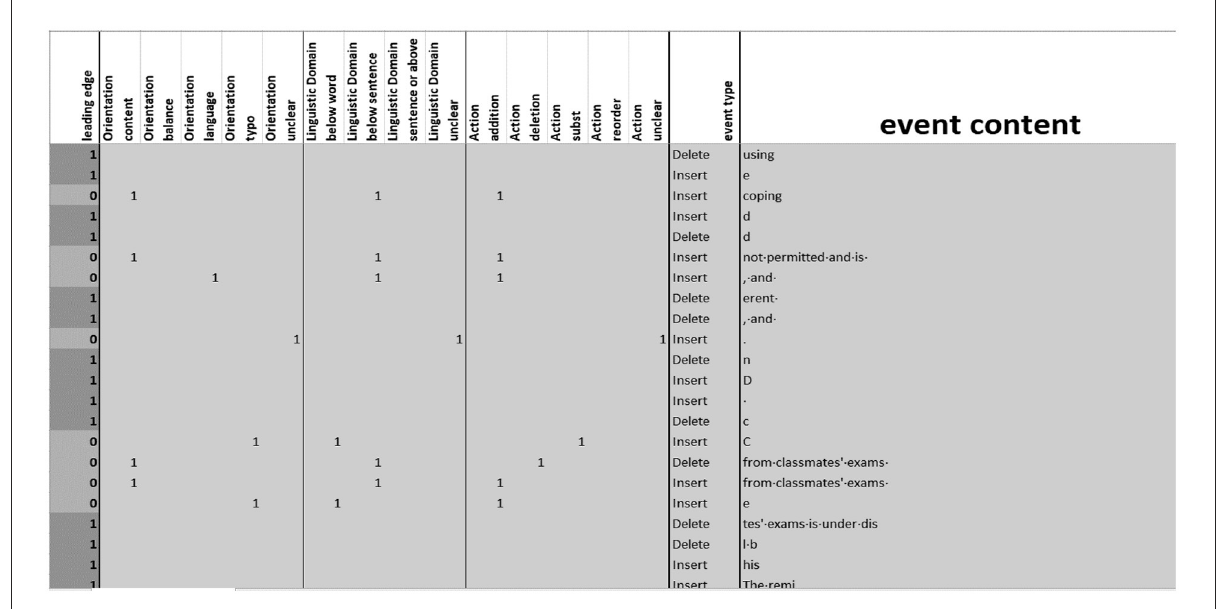
FIGURE2 The revision scheme spreadsheet.